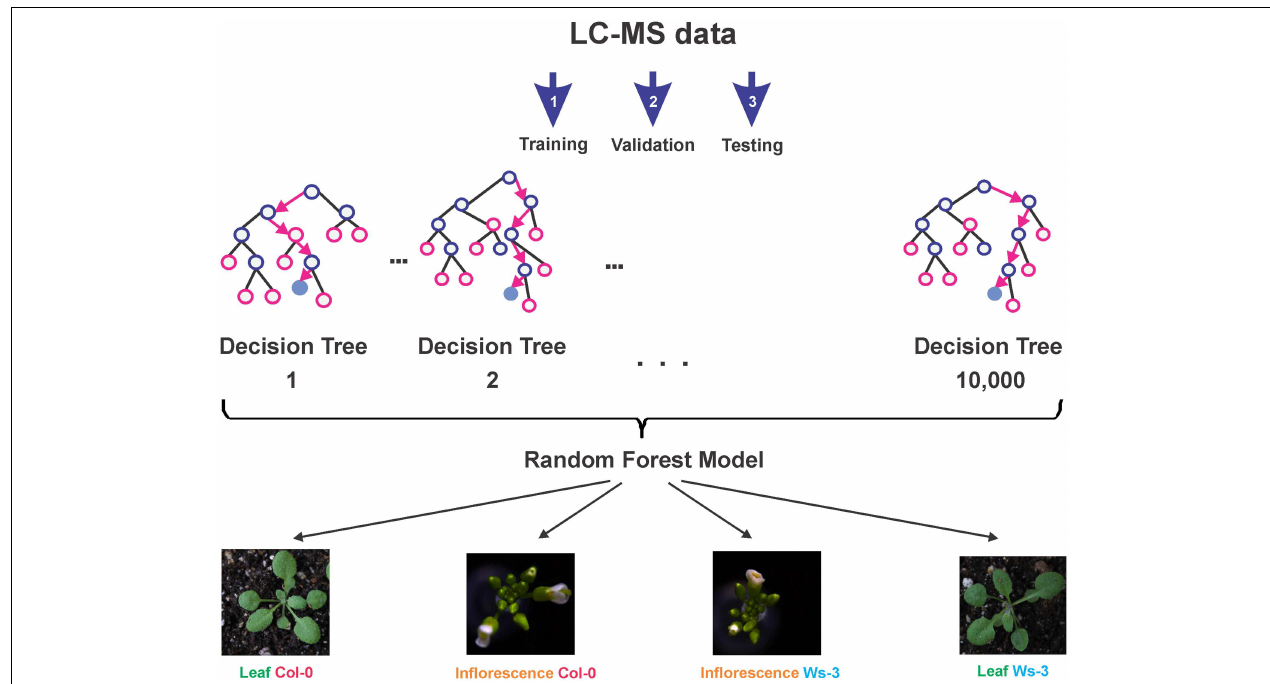
FIGURE 3 | Overview of the predictive Random Forest Model development. First the model is trained (Step 1), then the model is validated (Step 2), and finally the model is tested (Step 3). The final model (Supplemental Data 4) is able to reliably classify tissue type and accession, based on the LC-MS profile of a sample.